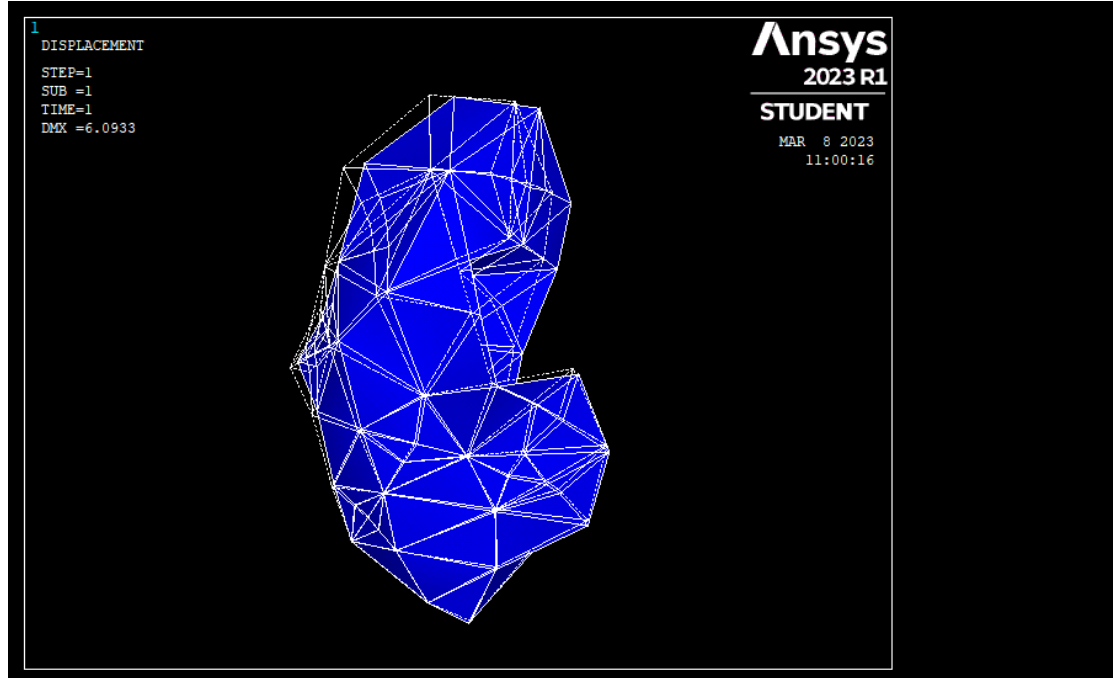
Figure 5. Undeformed and Deformed Geometry for Problem 2 (Linear Analysis).